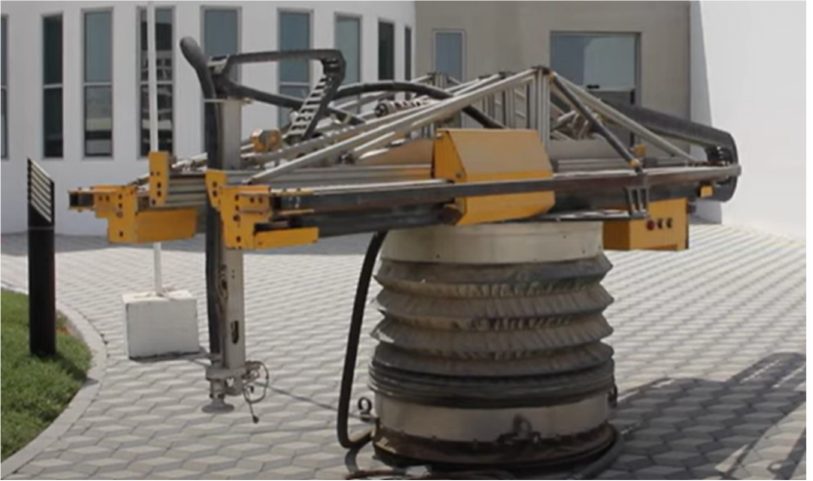
Figure 14. Apis Cor robotic arm printer [40]. Reprinted with permission from Ref. [40]. 2021, Jarett Gross.